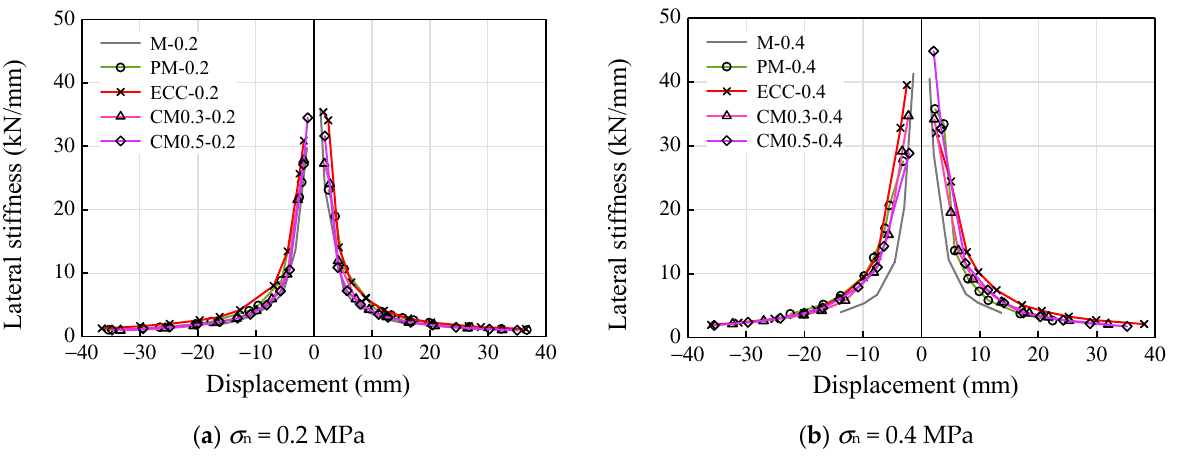
Figure 15. Lateral secant stiffness–displacement responses: ( a ) σ n = 0.2 MPa and ( b ) σ n = 0.4 MPa.